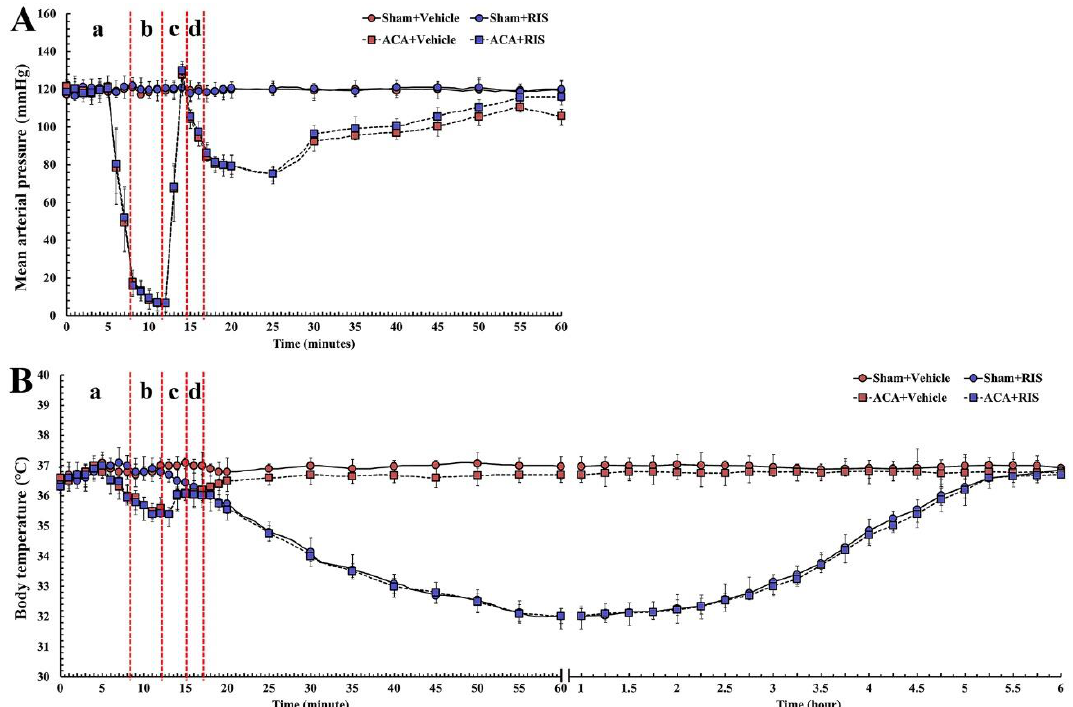
Figure 2. MAP ( A ) and body temperature ( B ) before, during, and after ACA in the Sham+vehicle, ACA/CPR+vehicle, and ACA/CPR+RIS groups. Note that body temperature in the ACA/CPR+RIS group was 33 ± 0.5 °C from 1 to 2 h after ACA. a, inducing ACA; b, maintaining ACA condition; c, conducting CPR; d, confirming ROSC. The bars indicate the means ± SEM ( n = 7).